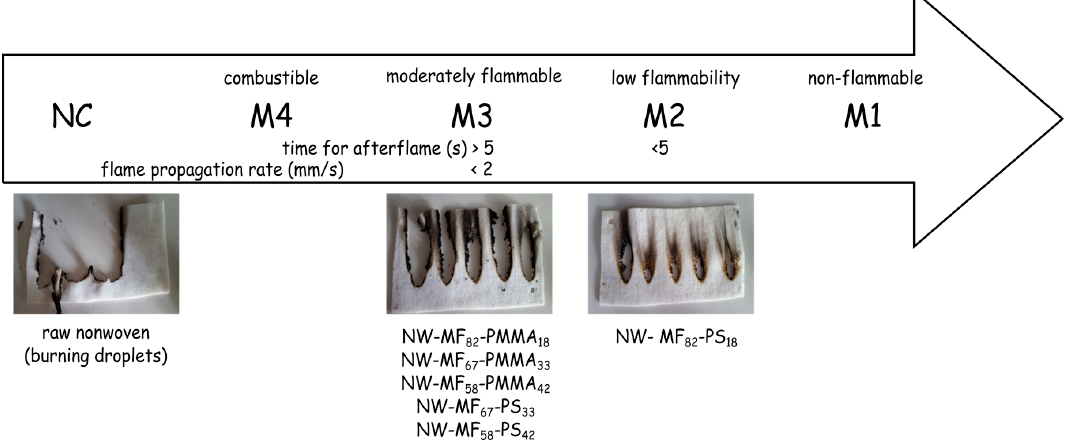
Figure 9. NF P 92-504 test results.